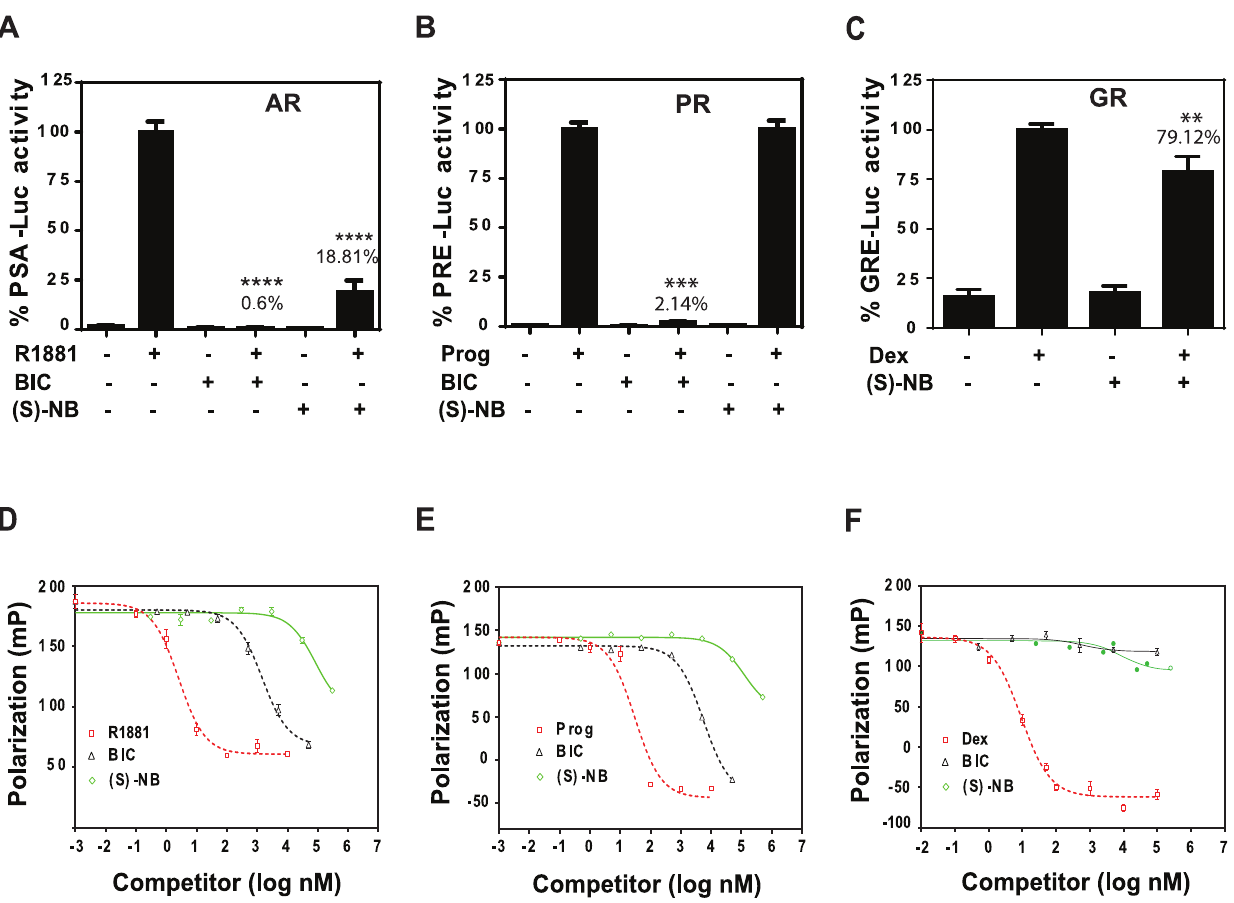
Figure 2. Niphatenone B inhibits AR activity. Effect of ( S )-niphatenone B, or bicalutamide (BIC) on R1881 induced endogenous AR transcriptional activity ( A ), 4-pregnene-3,20-dione (Prog, 10 nM) induced PR transcriptional activity (B), or dexamethasone (Dex, 10 nM) induced GR transcriptional activity (C) in LNCaP cells that were transiently transfected with PSA(6.1 kb)-luciferase reporter, PRE-luciferase or GRE-Luciferase reporters and expression vector for PR- b or GR. Luciferase activities were represented as percentage of vehicle activity. Data is presented as the mean 6 SEM (n=3). Representative competition binding curve showing displacement of 1 nM fluorescently labeled ligand from recombinant AR (D), PR (E), or GR (F) LBDs (25 nM) by bicalutamide (BIC), agonist R1881, progesterone or dexamethasone, and ( S )-niphatenone